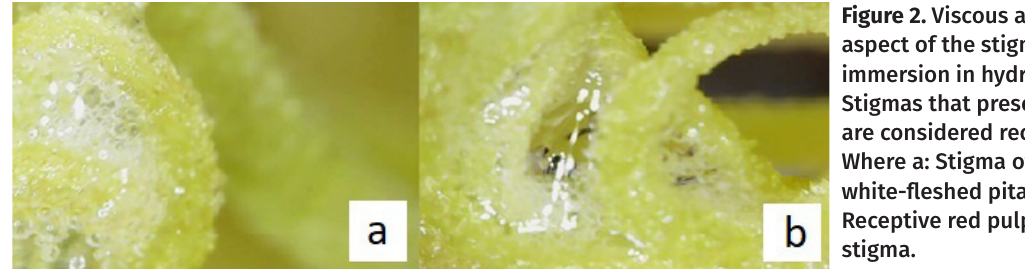
Figure 2. Viscous and humectant aspect of the stigma after immersion in hydrogen peroxide. Stigmas that present bubbles are considered receptive. Where a: Stigma of receptive white-fleshed pitaya flower; b: Receptive red pulp pitaya flower stigma.